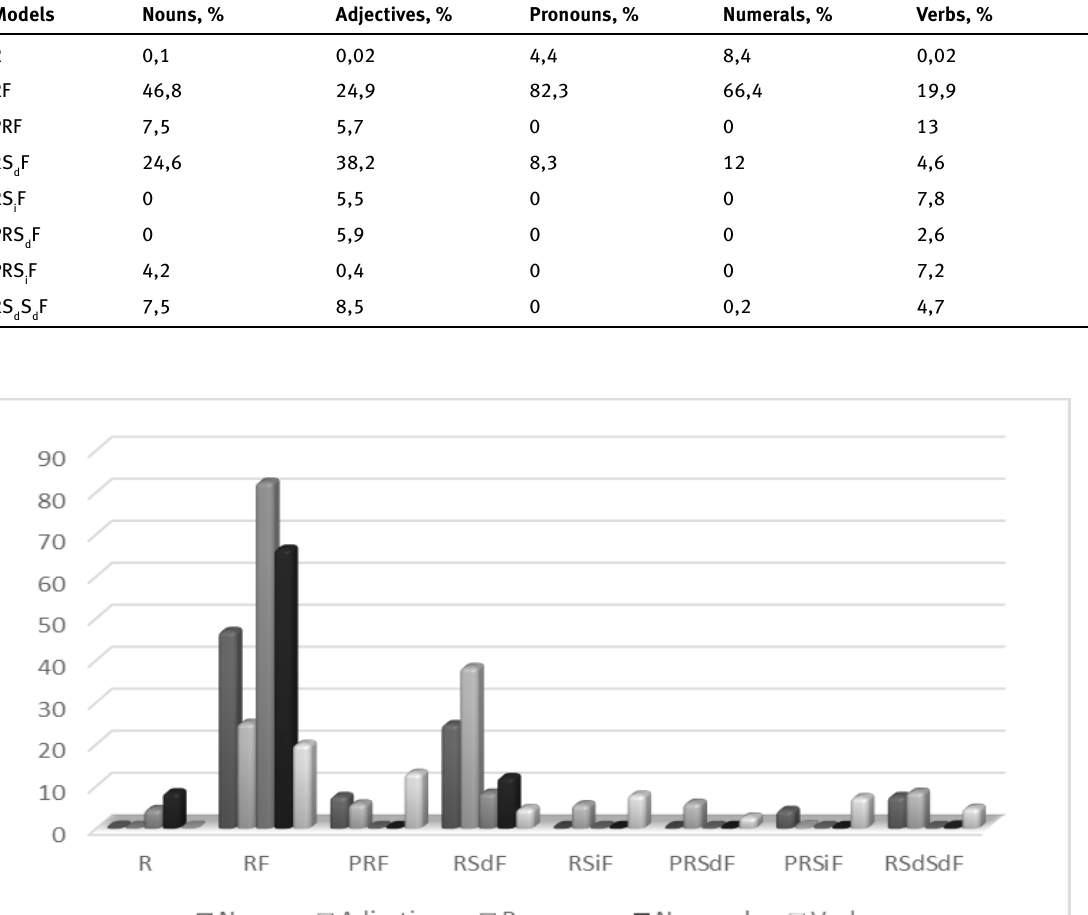
Table 3. Distribution of Morphemic Models across Different Parts of Speech Models